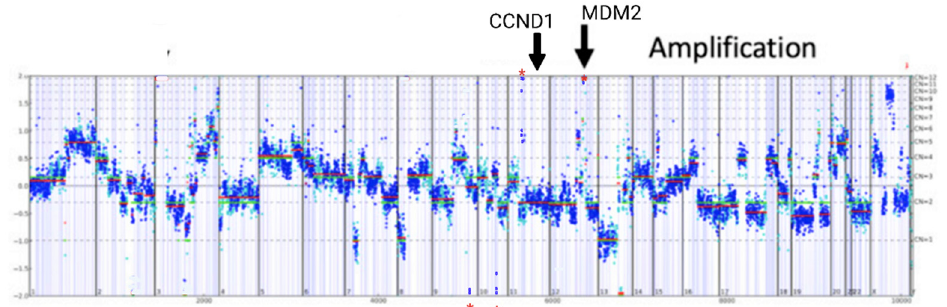
Figure 3. Comprehensive genomic profiling revealed multiple potentially targetable gene amplifications in CCND1 , FGF4 and MDM2 . Y-axes denote log-ratio measurements of coverage obtained in test samples versus a normal reference sample, with assessed copy numbers marked by dashed lines. Each point denotes a genomic region measured by means of the assay (blue, exon; cyan, SNP), and these are ordered by genomic position. Red lines indicate the average log-ratio in a segment, whereas green lines illustrate the model prediction. Asterisks denote the detected CCND1 (chr11) and MDM2 amplification (chr12).